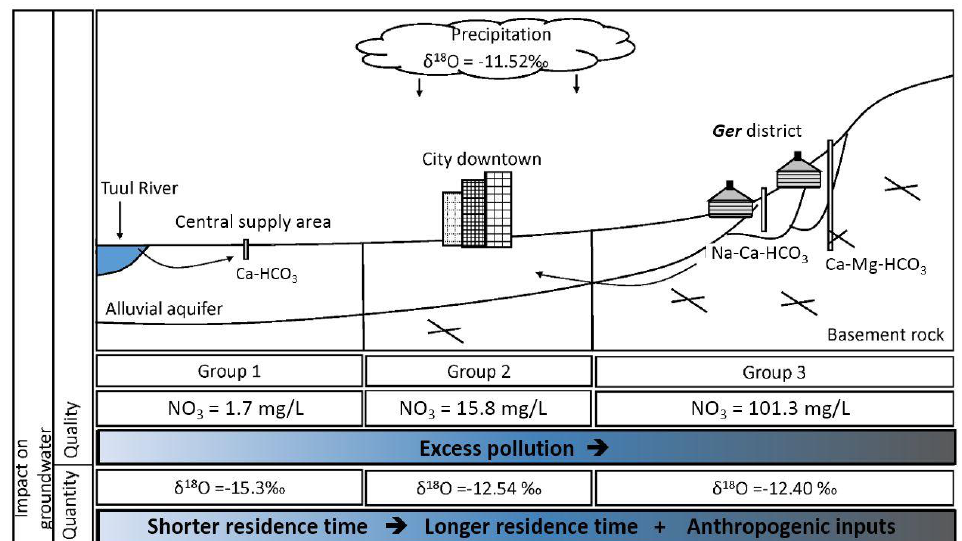
Figure 12. Schematic diagram of the groundwater flow system in Ulaanbaatar.